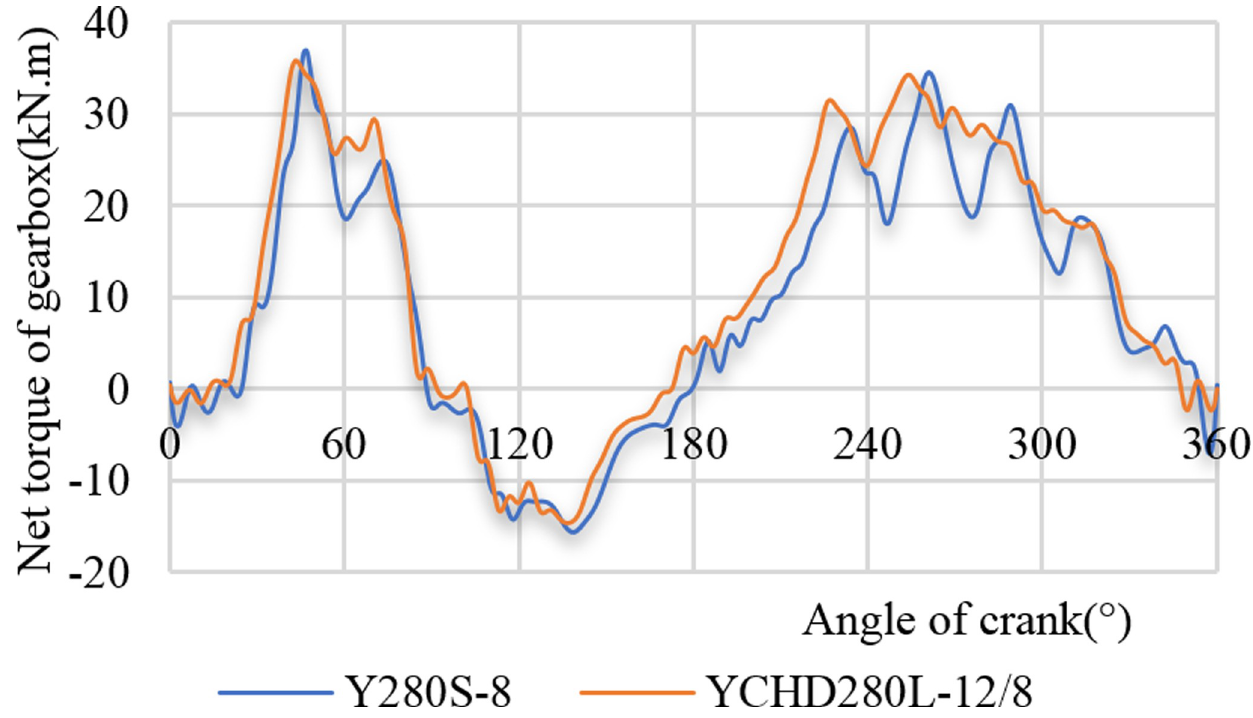
Fig 14. Comparison of output torque curve of the